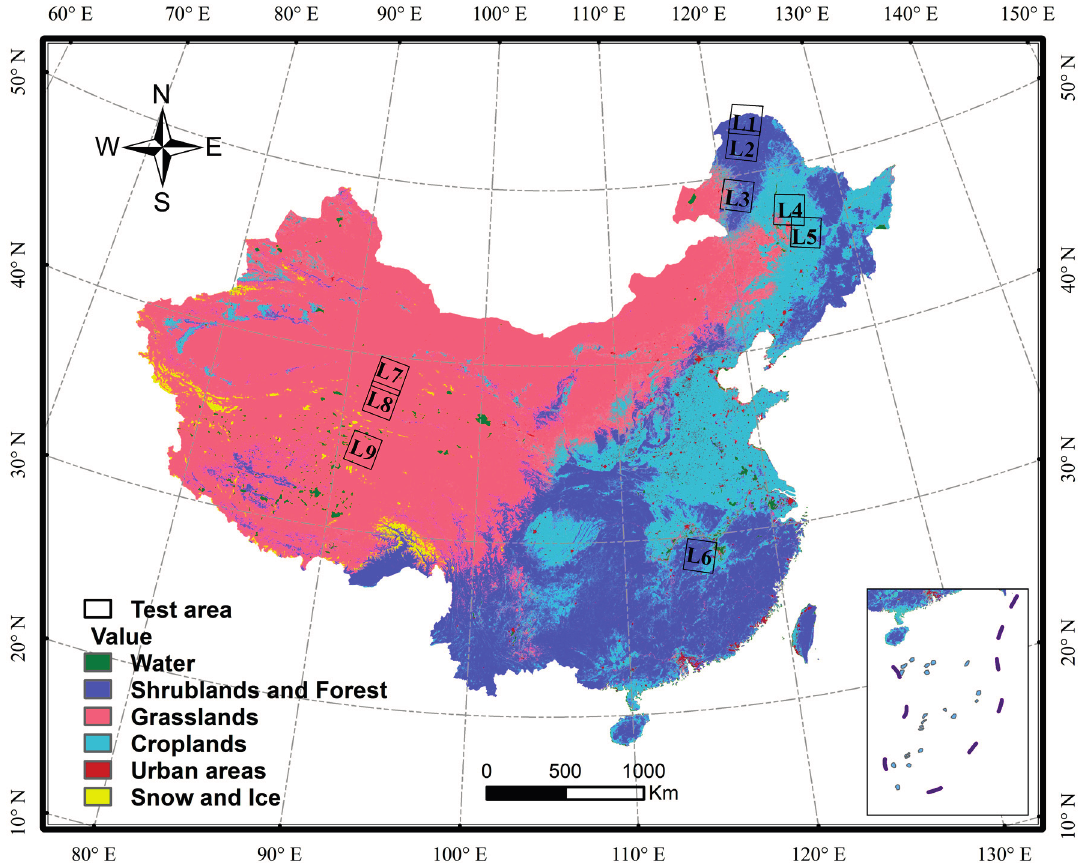
Figure 1. Spatial distribution of land cover types in